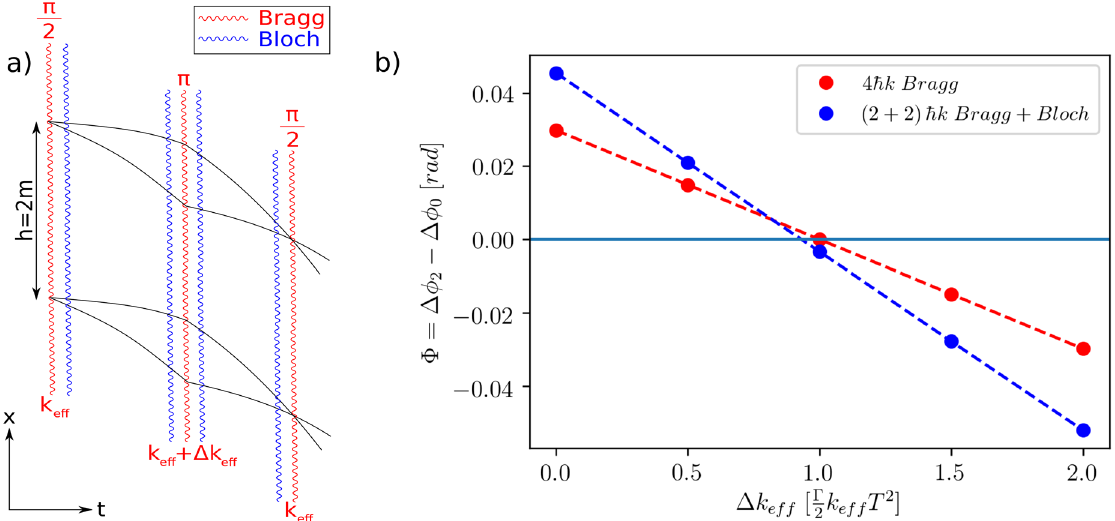
Figure 5. Gravity gradient cancellation in the case of a combined Bragg-Bloch gradiometer scheme. ( a ) Schematic of the Bragg-Bloch interferometer geometry with a baseline of 2 m. This configuration allows one to independently imprint momenta of n (cid:31) k Bragg and n Bloch (cid:31) k . The Bragg mirror pulse is momentum-adapted to cancel the gravity gradient phase. ( b ) Gradiometric phase for a 4 (cid:31) k (red dots) Bragg momentum transfer and a 2 (cid:31) k Bragg + 2 (cid:31) k Bloch Mach–Zehnder interferometer (blue dots). For both interferometers, the Gaussian pulse 50 µ s, respectively. The initial momentum 25 µ s and τ lengths of the splitting and mirror pulses are τ bs m = = 0.01 (cid:31) k. The corresponding Rabi frequencies for the higher order Bragg width of the atomic sample is σ p = transitions were found by optimising for an ideal 50 : 50 population splitting of the π 2 pulse, which leads to a 3.7 ω 2 2 ) (cid:31) k Bragg+Bloch geometry, the Bloch sequence is implemented Rabi frequency of (cid:31) 4 (cid:31) k r . For the ( = + 0.5 ms during which the 0.5 ms, a frequency chirp time of τ with an adiabatic loading time of τ load chirp = = 0.5 ms. The Rabi frequency of the momentum transfer occurs and an adiabatic unloading time of τ unload = 2 Ŵ 4 (cid:31) k Bragg geometry we find a vanishing gradiometer phase at � k 4 ω Bloch lattice is (cid:31) r . For the eff = 2 k eff T = 2 ) (cid:31) k Bragg+Bloch geometry we find a phase which agrees with the analytical calculation 40 . For the shell ( 2 + 2 due to the nontrivial correction of the space-time area of the Ŵ 3 mrad at � k shift of (cid:31) eff = 2 k eff T = − 2 ) (cid:31) k Bragg+Bloch compared to the 4 (cid:31) k Bragg geometry. The dashed lines are a guide to the ( 2 +